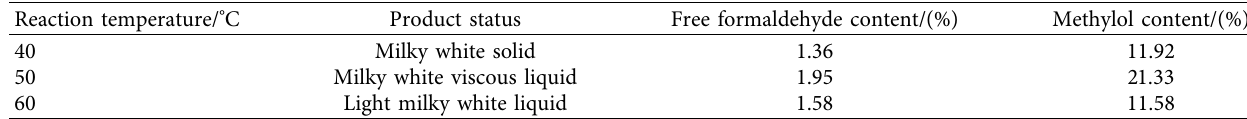
Table 4: Effect of reaction temperature on free formaldehyde and methylol content.